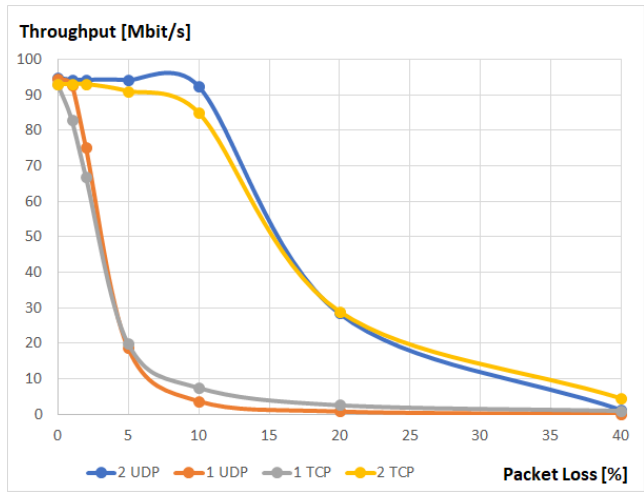
Figure 16. Data Transfer Throughput vs. Increasing Packet Loss on Bearer